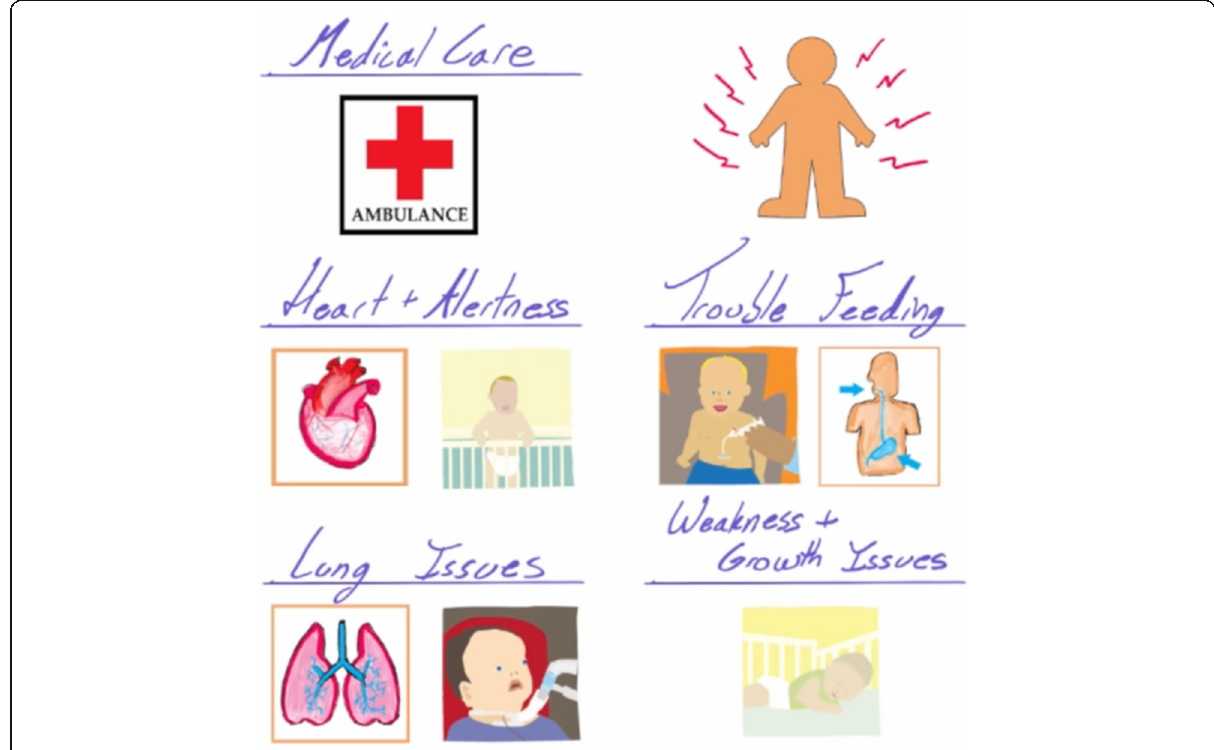
Fig. 2 Sample of a Health State